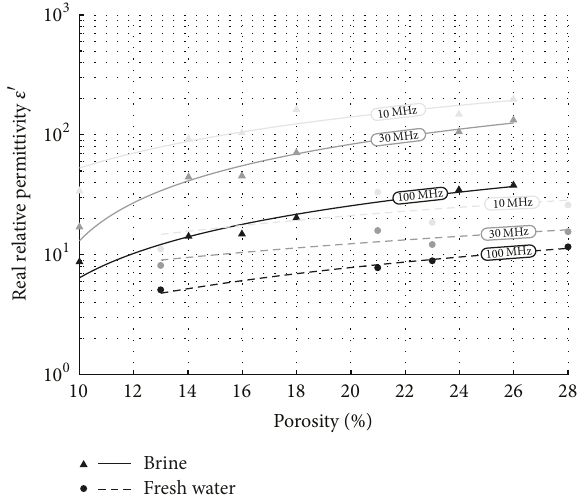
Figure 6: Dielectric response of brine saturated and fresh water samples at 100, 30, and 10 MHz.